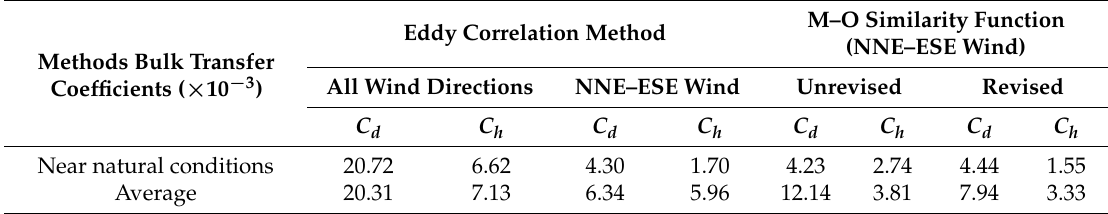
Table 6. Values of C d and C h calculated using different